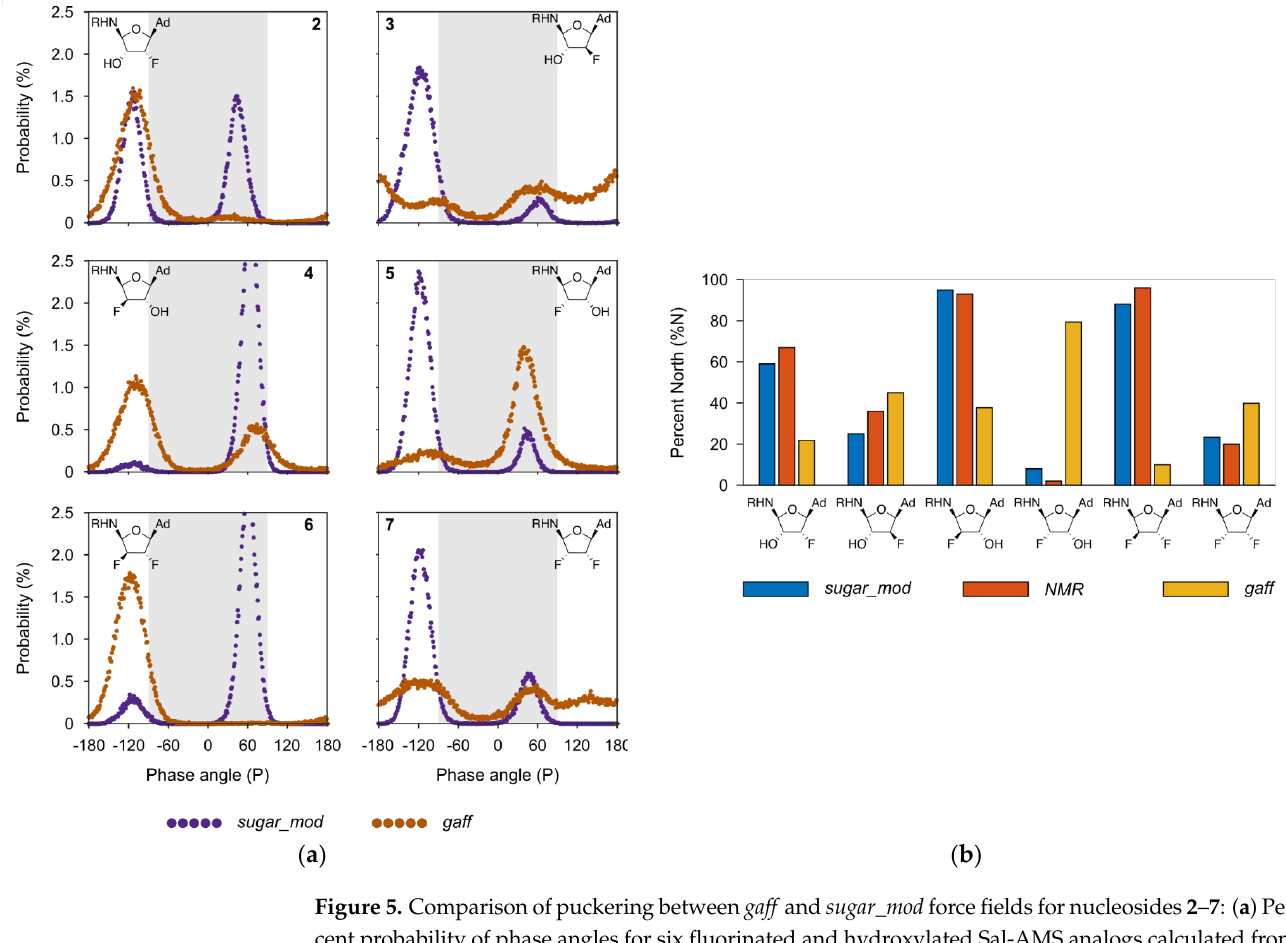
Figure 5. Comparison of puckering between gaff and sugar_mod force fields for nucleosides 2 – 7 : ( a ) Percent probability of phase angles for six fluorinated and hydroxylated Sal-AMS analogs calculated from unrestrained MD simulations using the IpolQ + sugar_mod (purple) and AM1-BCC + gaff parameters (brown). The light grey shaded region shows the North configuration region, i.e., − 90 ≤ P ≤ 90; ( b ) Comparison of total percent North (% N) probability for the six fluorinated and hydroxylated Sal-AMS analogs calculated from unrestrained MD simulations using the IpolQ + sugar_mod (blue) and AM1-BCC + gaff parameters (yellow) compared to the literature experimental NMR values